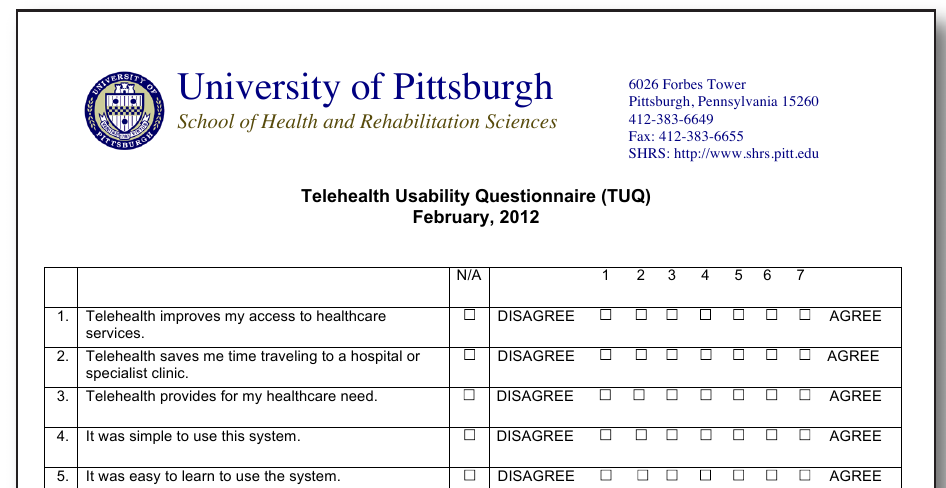
Figure 2: Telehealth Usability Questionnaire (Parmanto et al.,